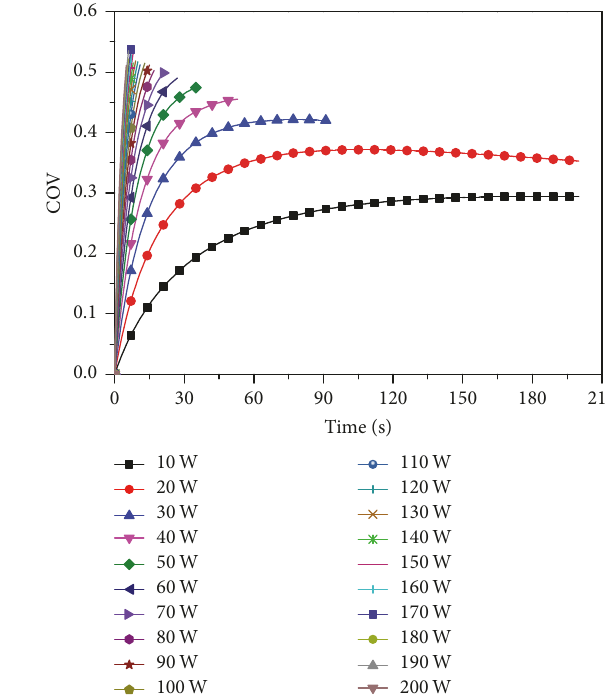
Figure 4: Maximum temperature of different input power.